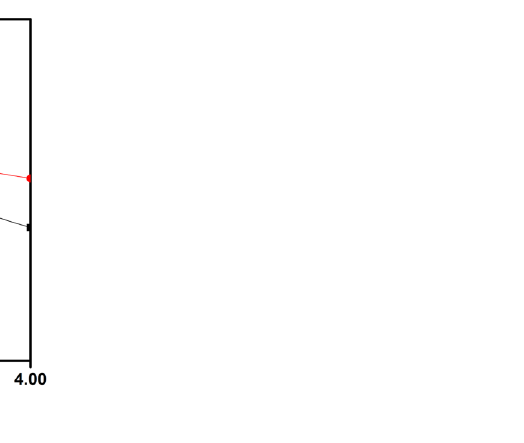
Figure 23. Total efficiency of projected eight members MIMO